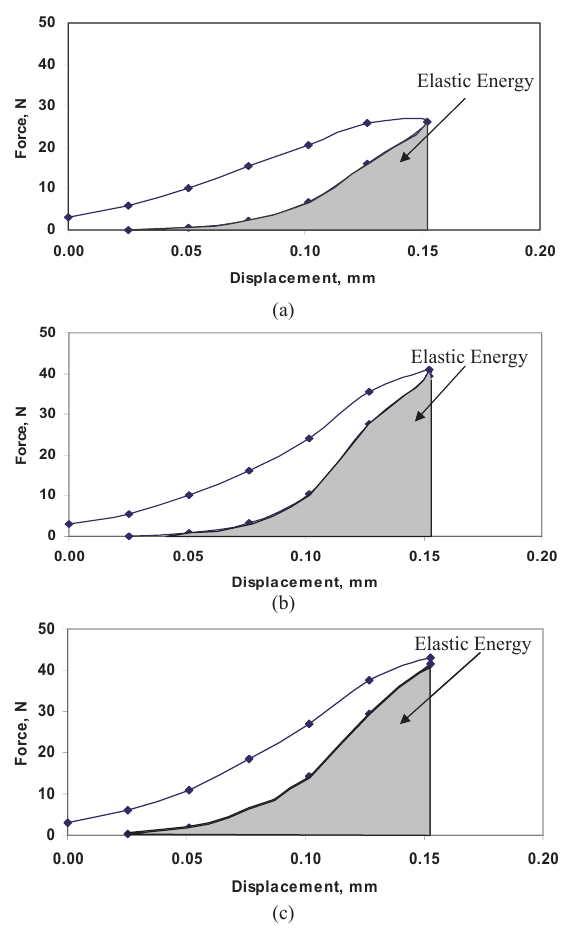
Fig. 10 Force vs. displacement (loading-unloading before failure) plot for tablet formed at 90 MPa using dry formulation in (a) diametral strength test, (b) axial penetration test, and (c) indentation hardness test